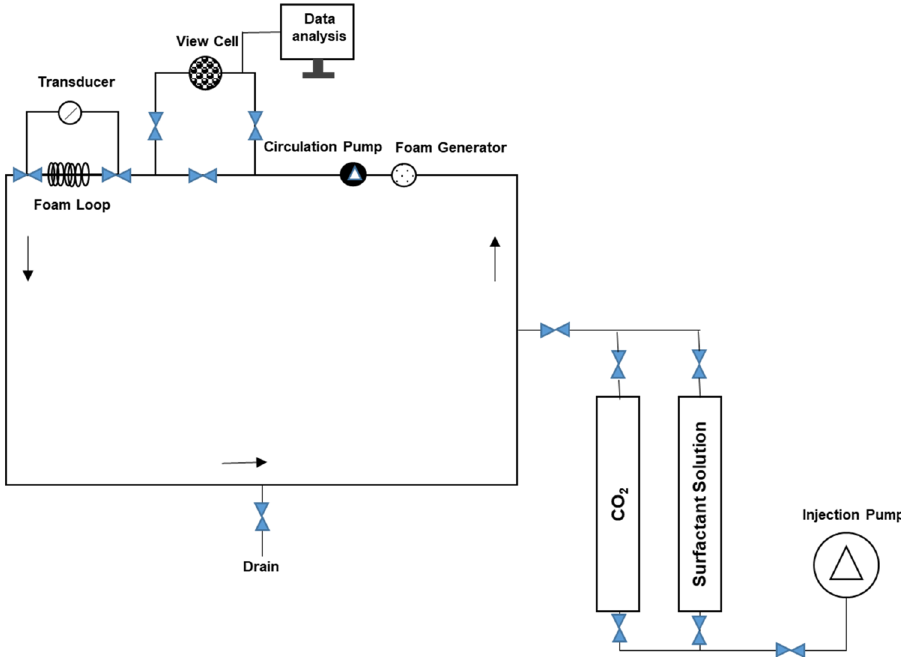
Figure 4. Schematic of the custom-built, high-temperature high-pressure foam loop